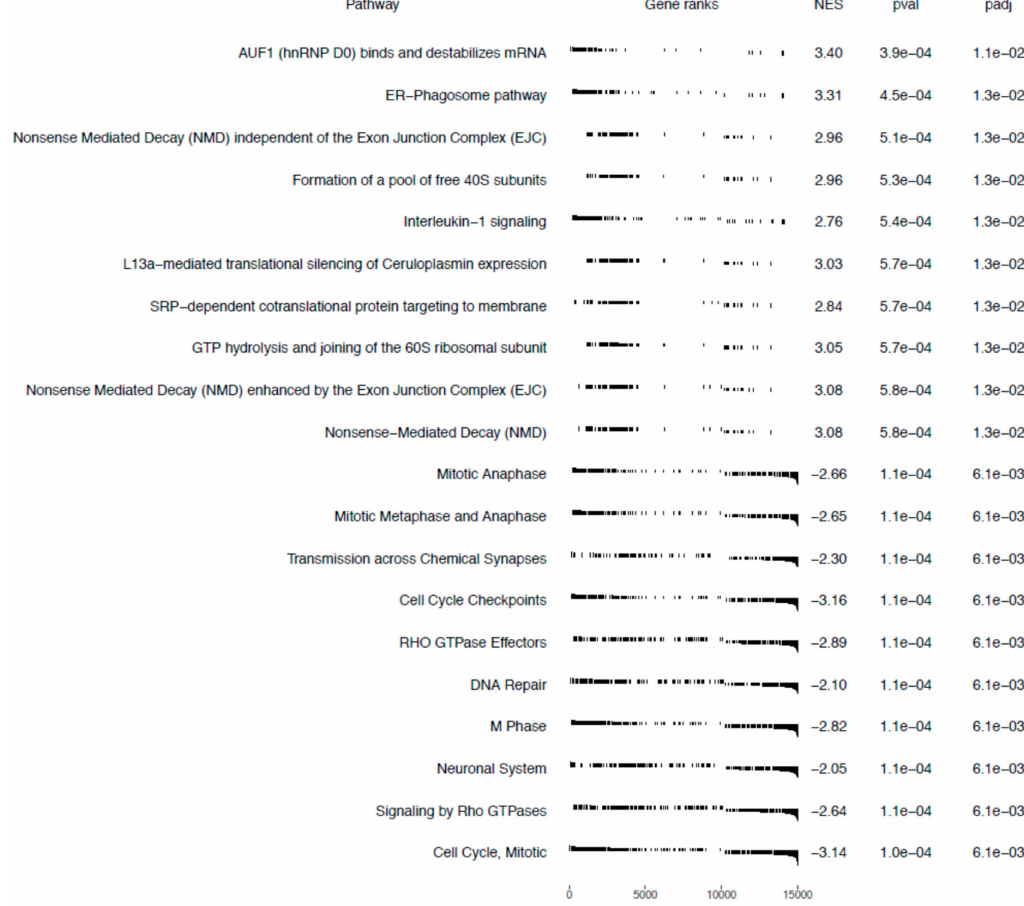
Figure 8. Gene sets enriched in bortezomib-treatment PC12-derived nerve cells. Gene sets are ranked according to the normalized enrichment score